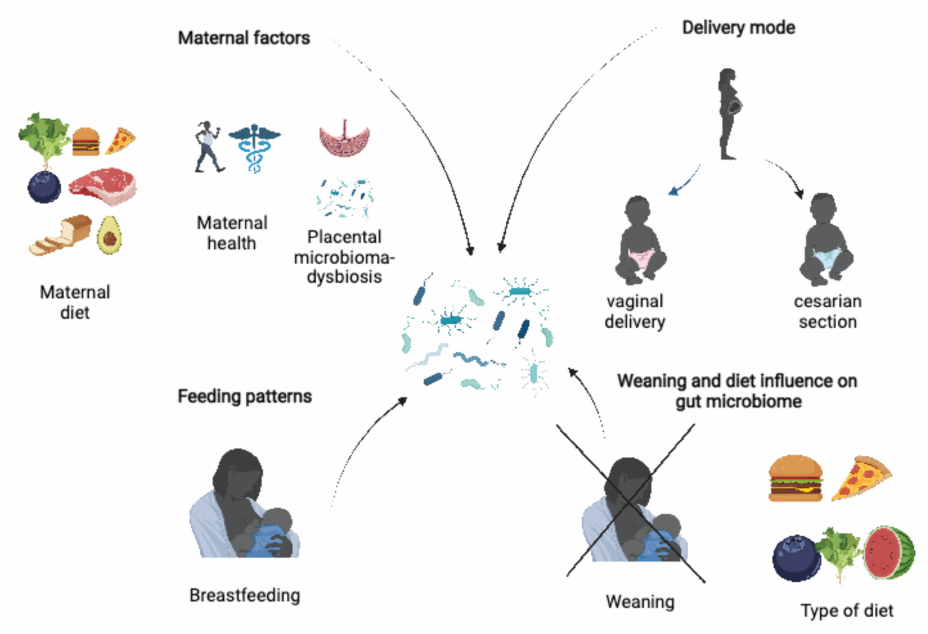
Figure 2. Factors influencing gut microbiome in children (created with www.BioRender.com, accessed on 6 February